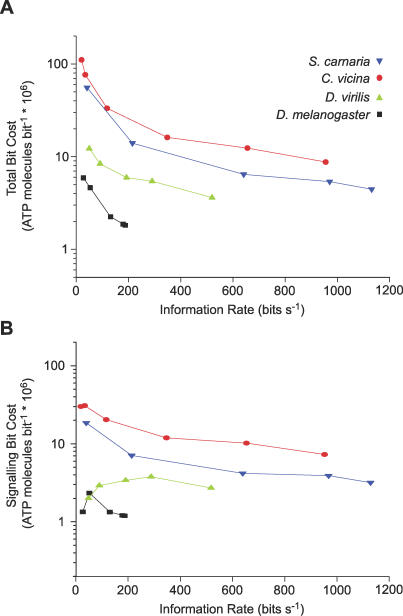
The Metabolic Cost of Information in R1–6 Photoreceptors Decreases When the Information Rate Is Increased by Raising the Light Level(A) The metabolic cost per bit plotted logarithmically versus the bit rate for R1–6 photoreceptors of the four species S. carnaria (blue), C. vicina (red), D. virilis (green), and D. melanogaster (black).(B) The metabolic cost of signalling per bit plotted logarithmically versus the bit rate for R1–6 photoreceptors in the four species.